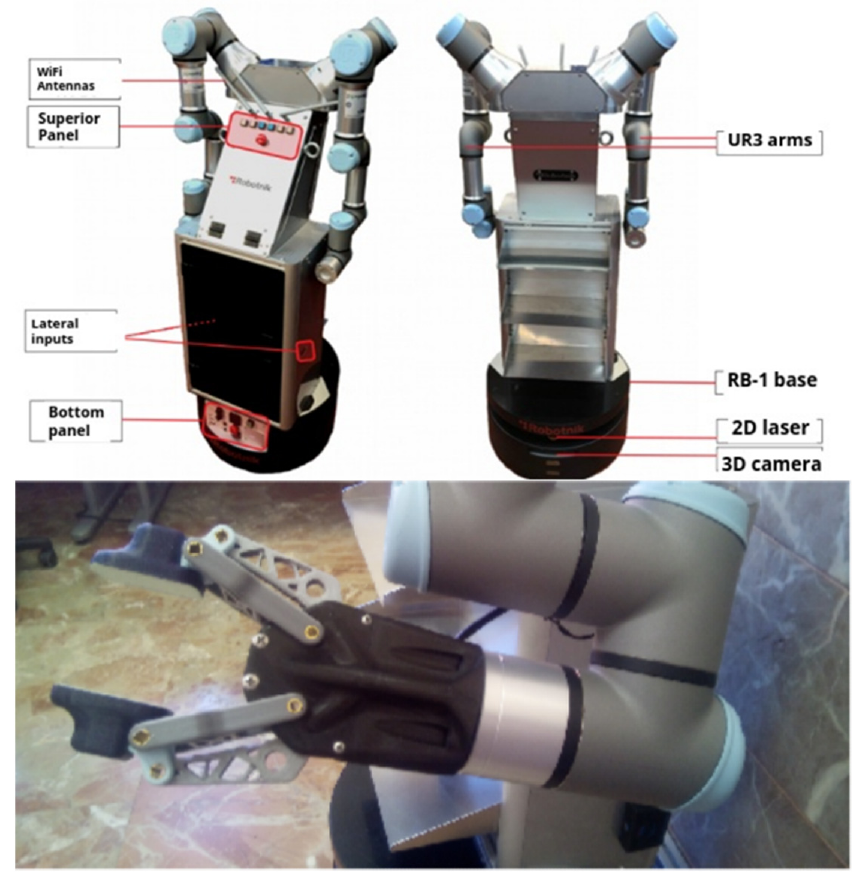
Figure 5. ADAM twin-arm manipulator robot and gripper.